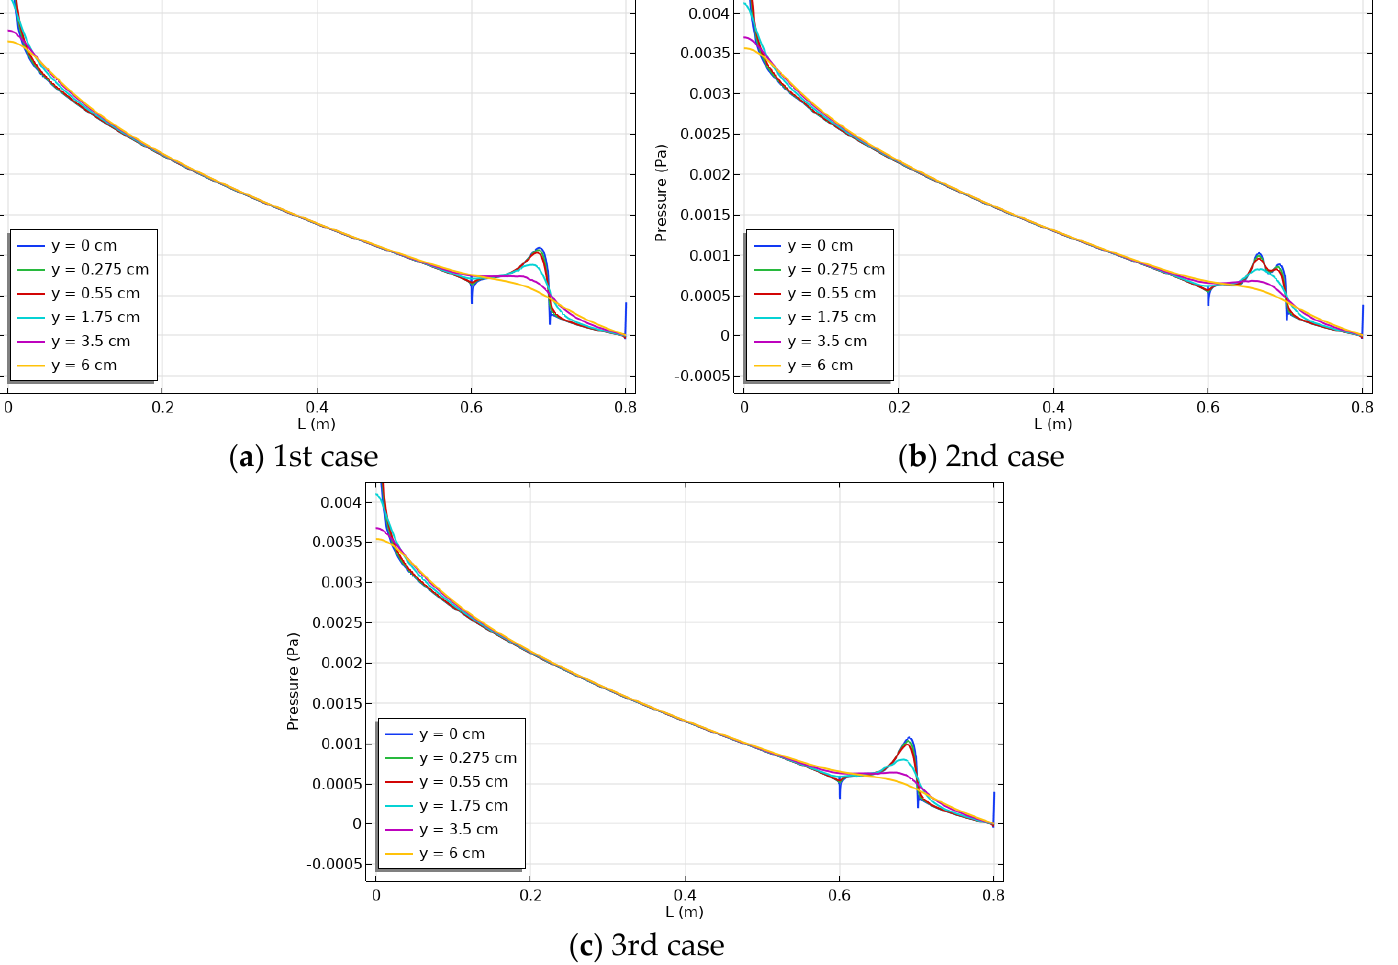
Figure 8. Pressure profile during the positive y axis in the assembly .